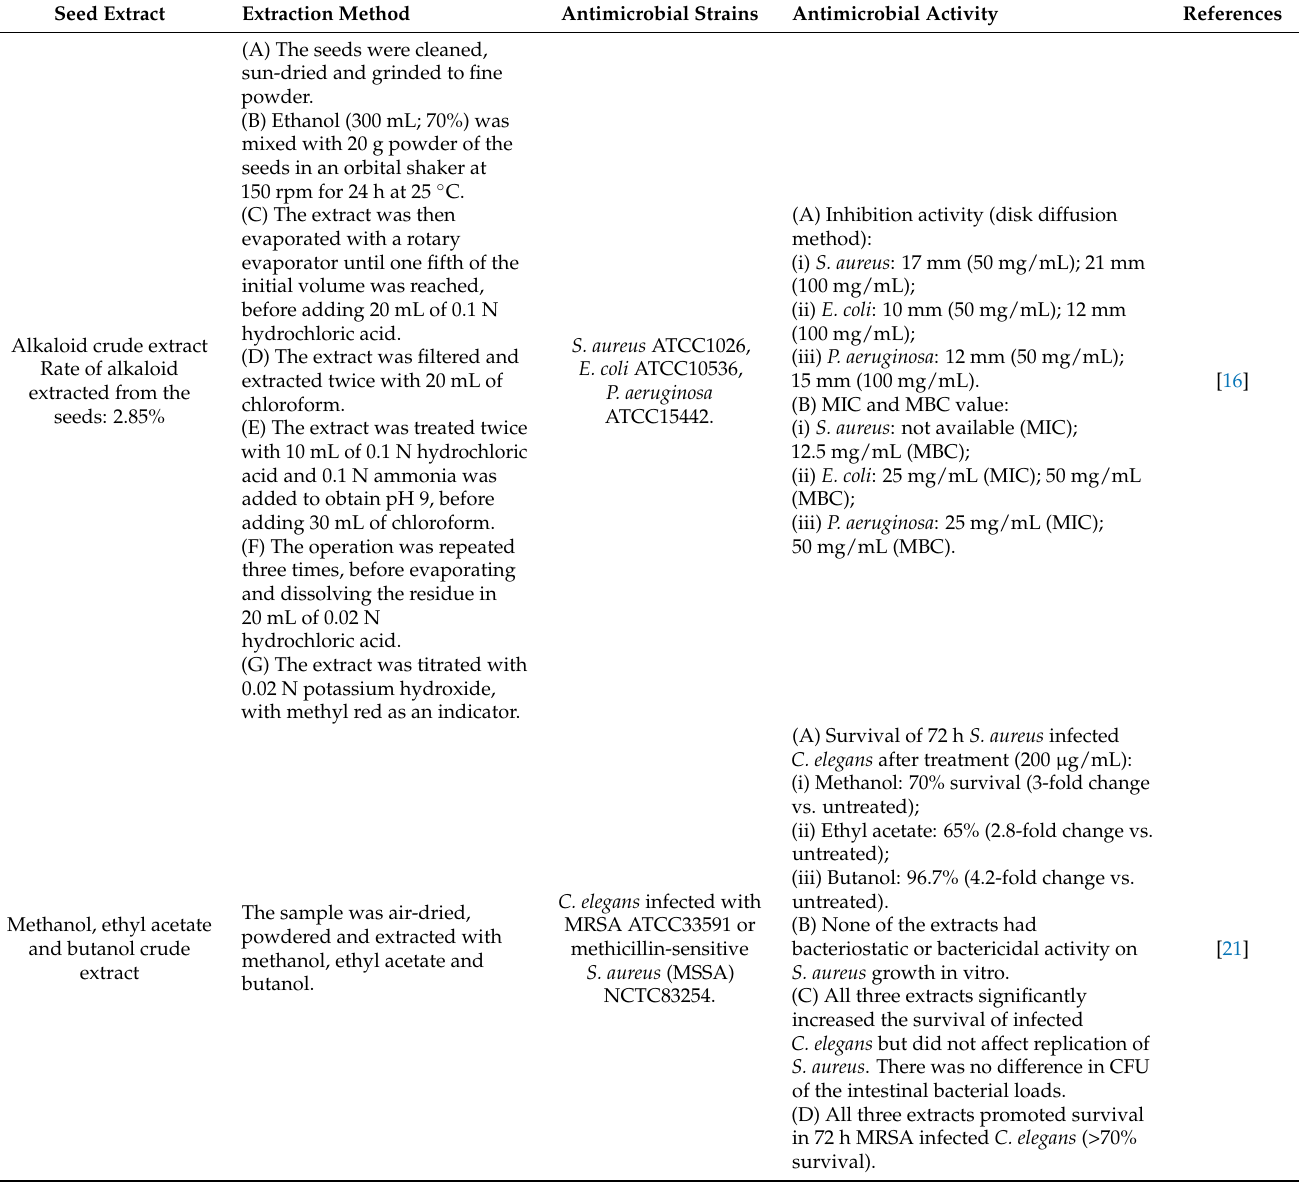
Table 1. The antimicrobial activity of S. macrophylla seed against various antimicrobial